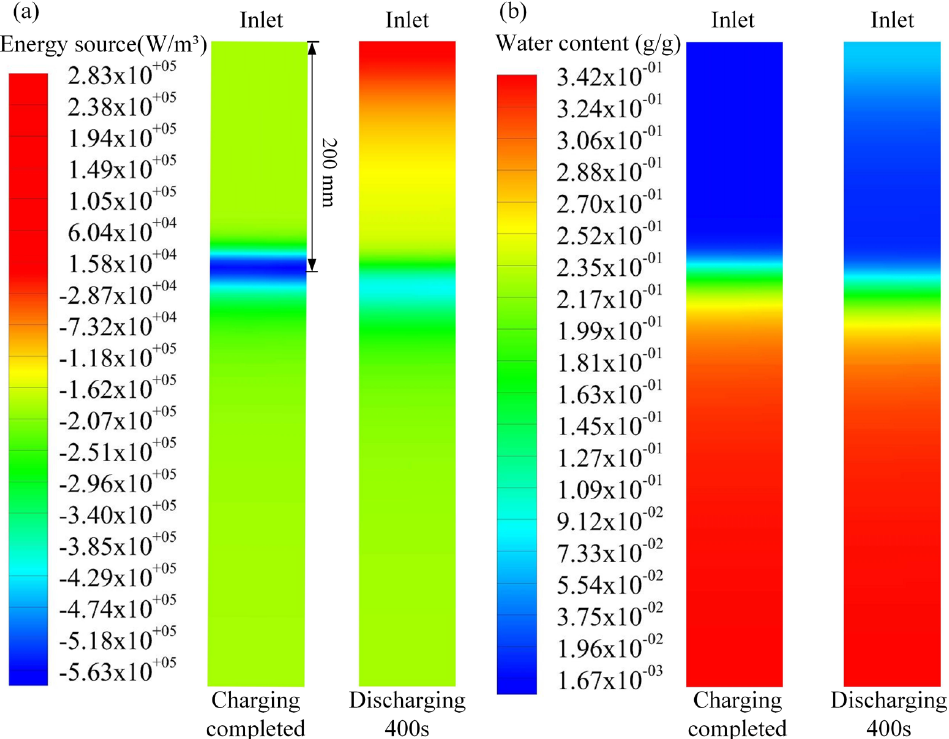
Figure 8. Distribution cloud of ( a ) energy source phase and ( b ) water content of materials in the reactor after the charging and at 400 s of the discharging under the condition of a charging level of 40%.